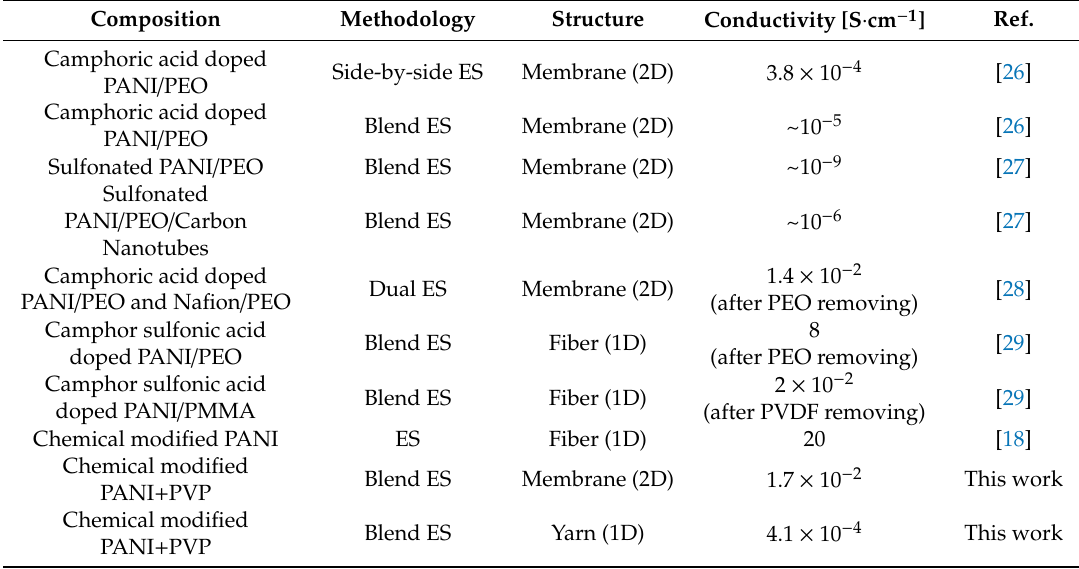
Table 2. Summary of several PANI-based conductive membranes using electrospinning technique found in literature and the present work.